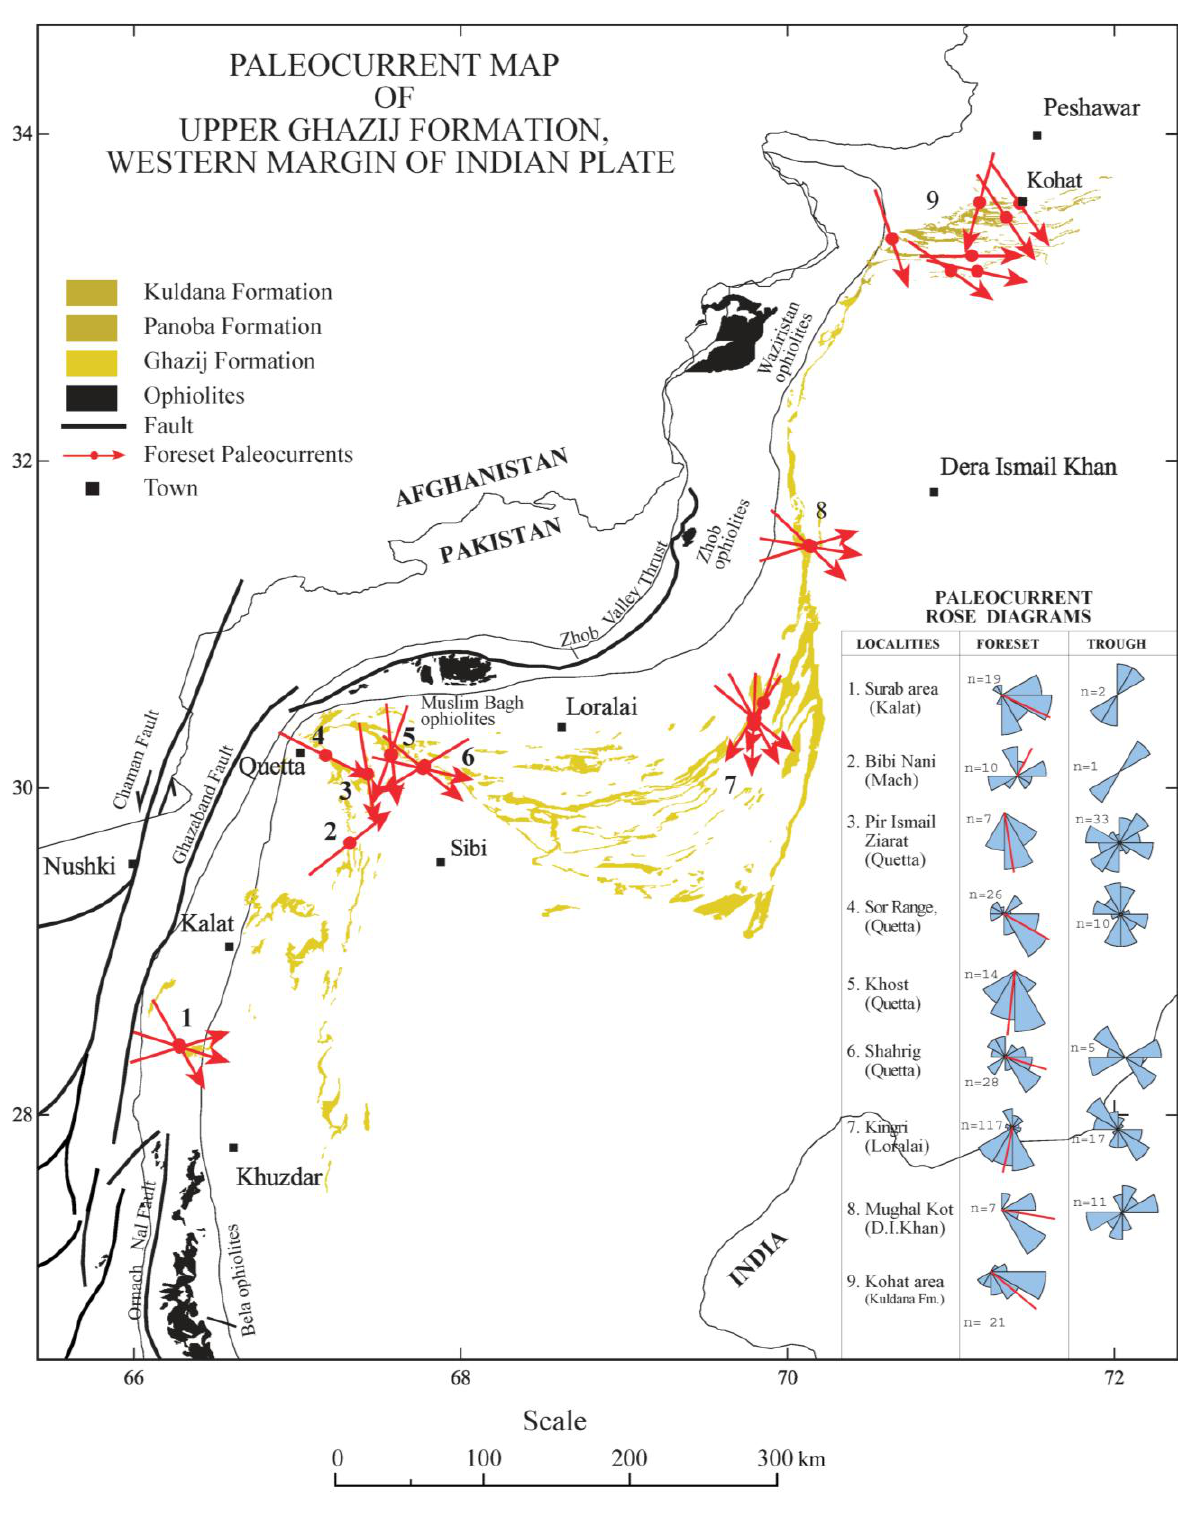
Figure A7. Paleocurrent map of upper Ghazij and Kuldana Formations showing paleoflow and dominant sediment transport directions along western margin of the Indian Plate during early and late early Eocene time. The foreset and trough paleocurrents indicate dominantly eastsoutheastward